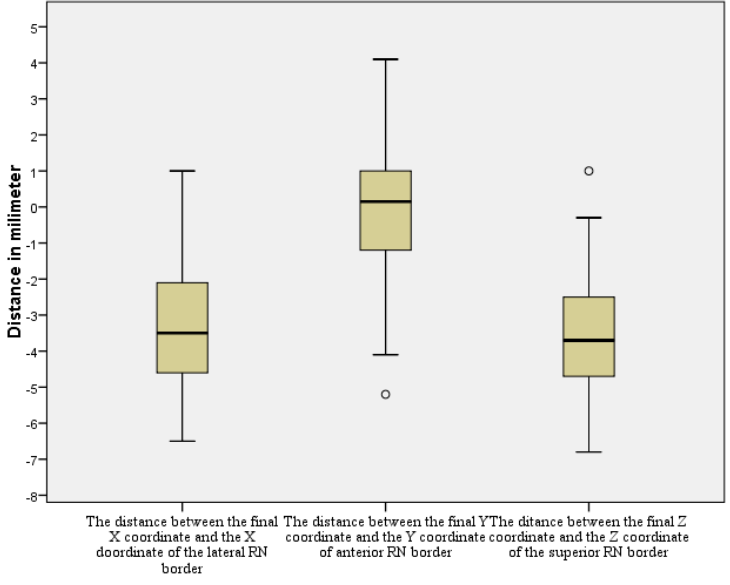
Figure 15. The distances between the different red nuleus (RN)borders and the final active electrode coordinates. ° : outliers.